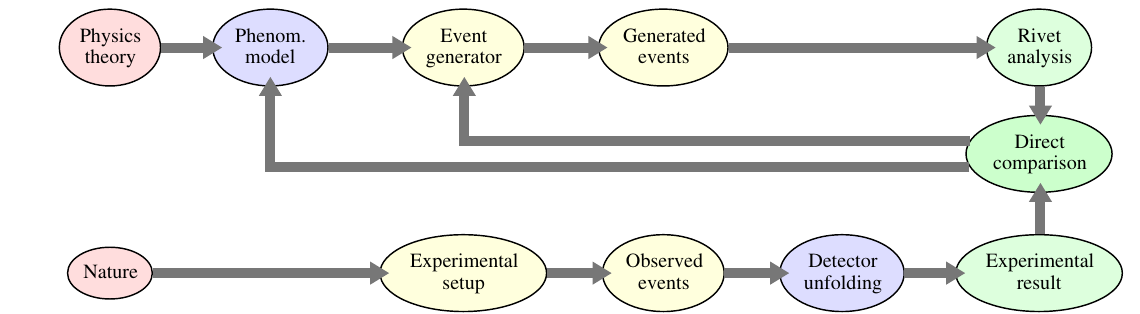
Fig. 1 Outline of how Rivet connects experimental analyses to theory and validation, with the typical workflow of a physics program shown. Onthetoprow,atypicaltheoreticalworkflowisdepicted,wherephysics